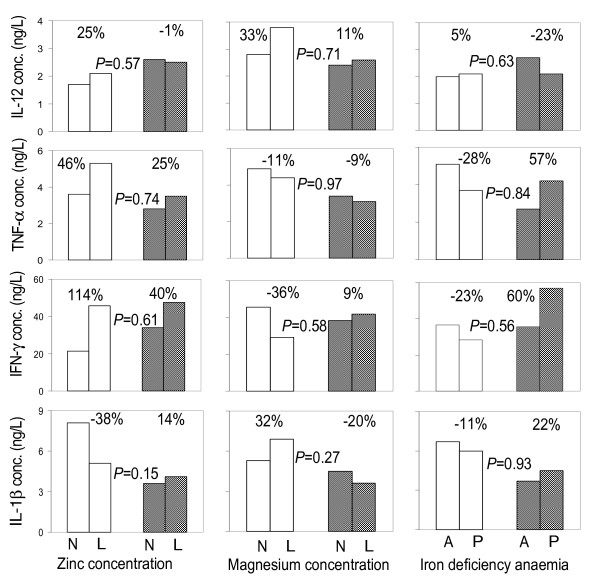
Associations between micronutrient status and supernatant type I cytokine concentrations following 7 days of PBMCs stimulation with Plasmodium falciparum-infected erythrocytes, by malaria infection status of the child at the time of blood collection. N: Normal concentrations; L: low concentrations; A: absent; P: present. Percentages indicate paired group differences in cytokine concentrations. Data from children without and with malaria infection at the time of blood collection are indicated with open and shaded bars, respectively. P-values indicates the interaction between nutrition and malaria infection status.